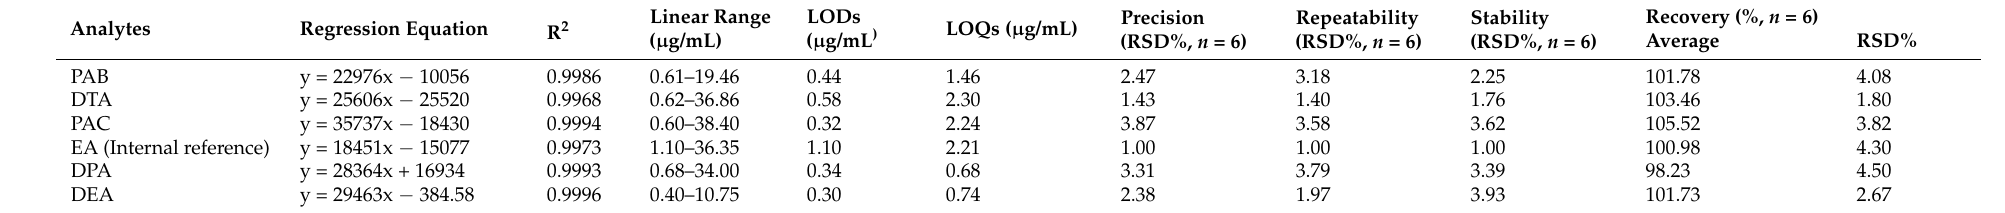
Table 2. Results of the validation procedure of reference substances ( n = 6).